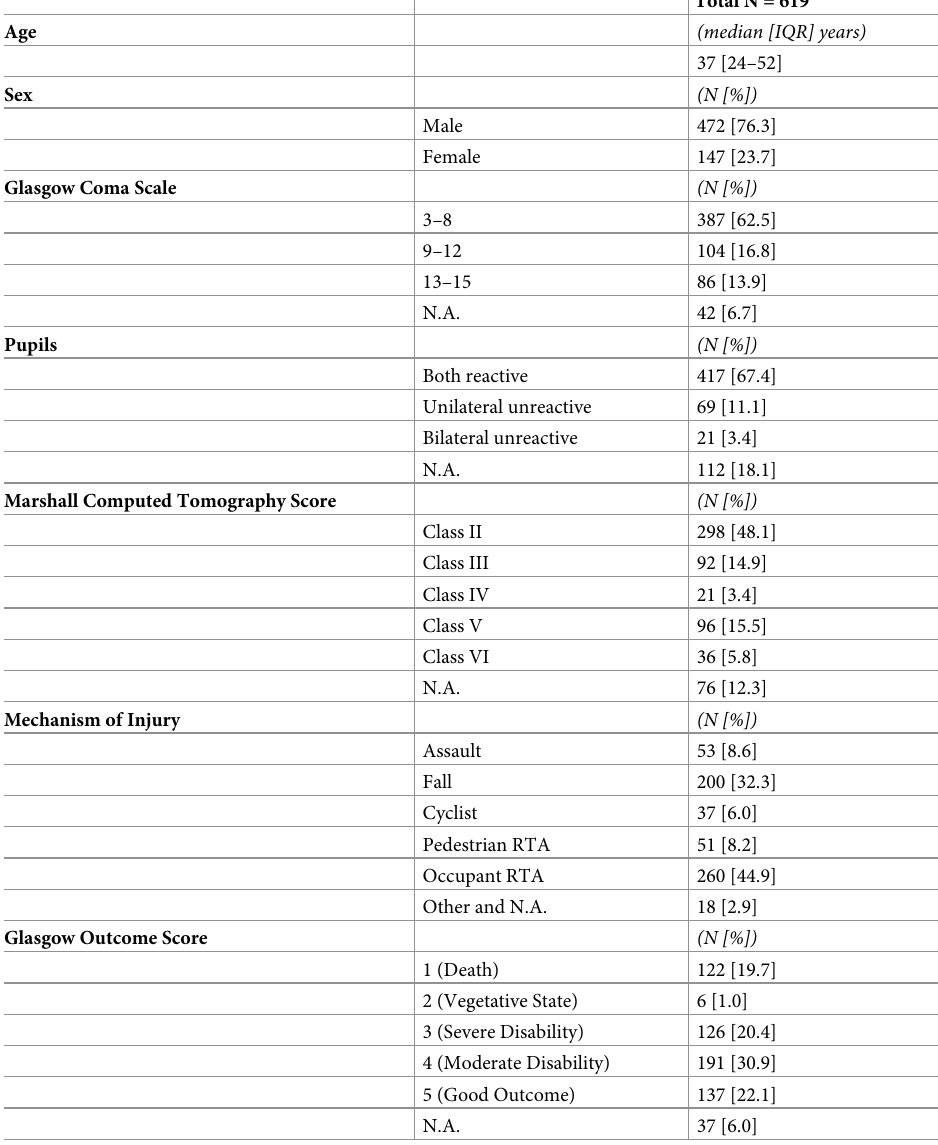
Table 1. Admission characteristics and outcomes of the patient